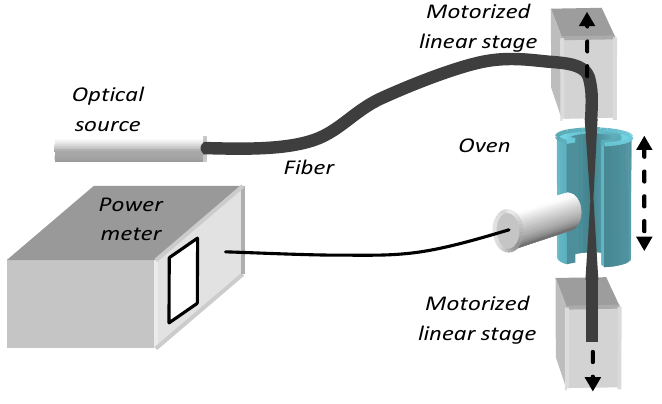
Figure 1. Fiber taper drawing setup.